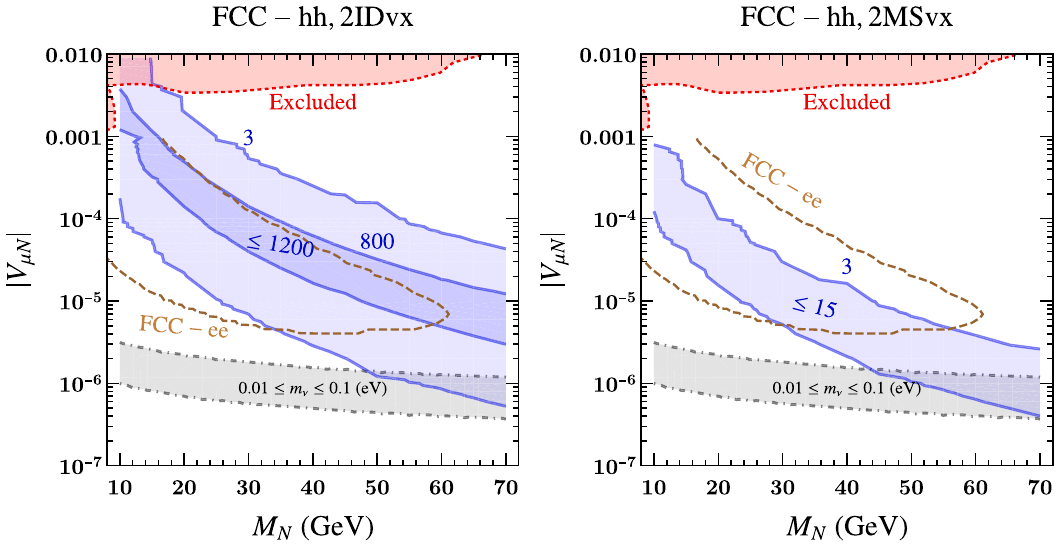
Fig. 14 Numberof2IDvx(left)and2MSvx(right)eventsasafunction browndashedlinerepresentstheFCC-eeprojection[69,70],andthered shaded region indicates current limits [71,72]. The grey band illustrates of the RHN mass M N and the active-sterile neutrino mixing strength | V μ | , at the FCC-hh with L = 30 ab − 1 for M = 8 TeV, g (cid:2) = 0 . 1 the range of | V μ N | required to generate light neutrino masses between N Z (cid:2) (solid blue lines and shaded regions). The value following the ≤ symbol 0 . 01 eV and 0 . 1 eV through the seesaw mechanism, m ν = | V μ N | 2 M indicates the approximate maximal number of events in each case. The